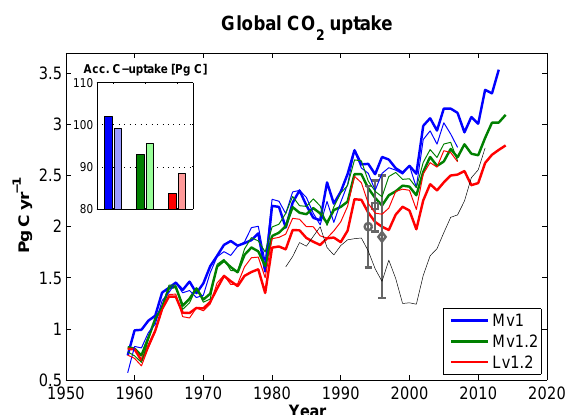
Figure 20. Globally integrated annual ocean carbon sink flux 1959– 2014 for Mv1 (blue lines), Mv1.2 (green), and Lv1.2 (red). Thick (thin) lines indicate carbon fluxes simulated with the model forced by the NCEP-C-IAF (CORE-IAF) data set. The total integrated flux from 1959 to 2007 is given in the inset, where the paler shading in- dicates results for simulations with CORE-IAF. The thin black line is the carbon flux estimate by Landschützer et al. (2015a) assuming a constant 0.45Pgyr − 1 contribution of riverine outgassing flux as in Le Quéré et al. (2015). Symbols with error bars are the carbon uptake estimates by McNeil et al. (2003) (circle), Mikaloff Fletcher et al. (2006) (square), and Manning and Keeling (2006) (diamond). Note that the estimates of McNeil et al. (2003) and Manning and Keeling (2006) are mean uptake values over the